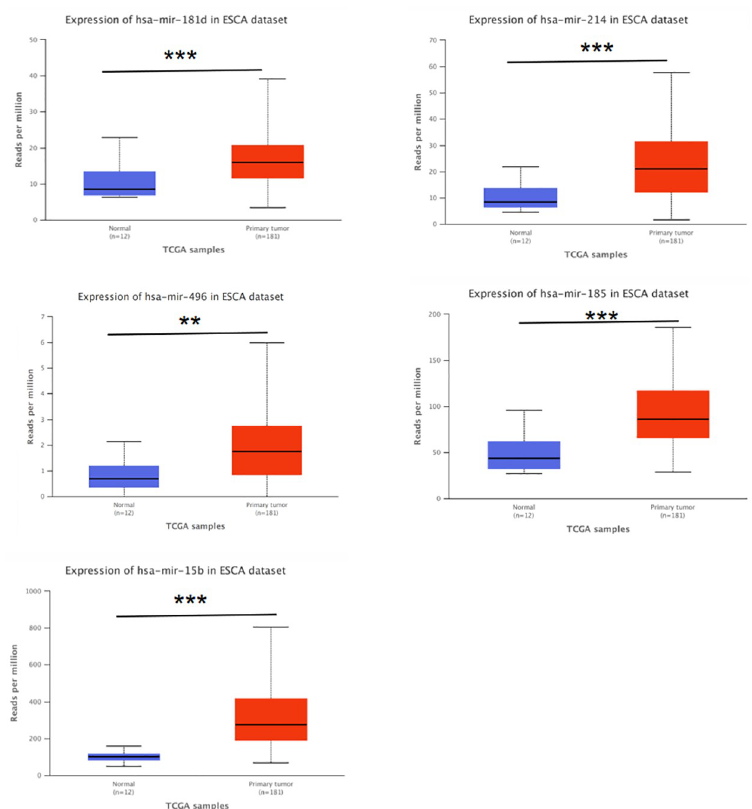
Fig 7. Expression of significant DEMs in the TCGA datasets. Expression of significant DEMs between EAC and normal tissue in the TCGA dataset. Red column represents the expression of EAC, blue column represents the expression of normal tissue. The horizontal axis represents different specimens, the vertical axis represents the number of reads from a gene per kilobase length per million reads. � respresents the P value < 0.05, �� respresents the P value < 0.01, ��� respresents the P value <